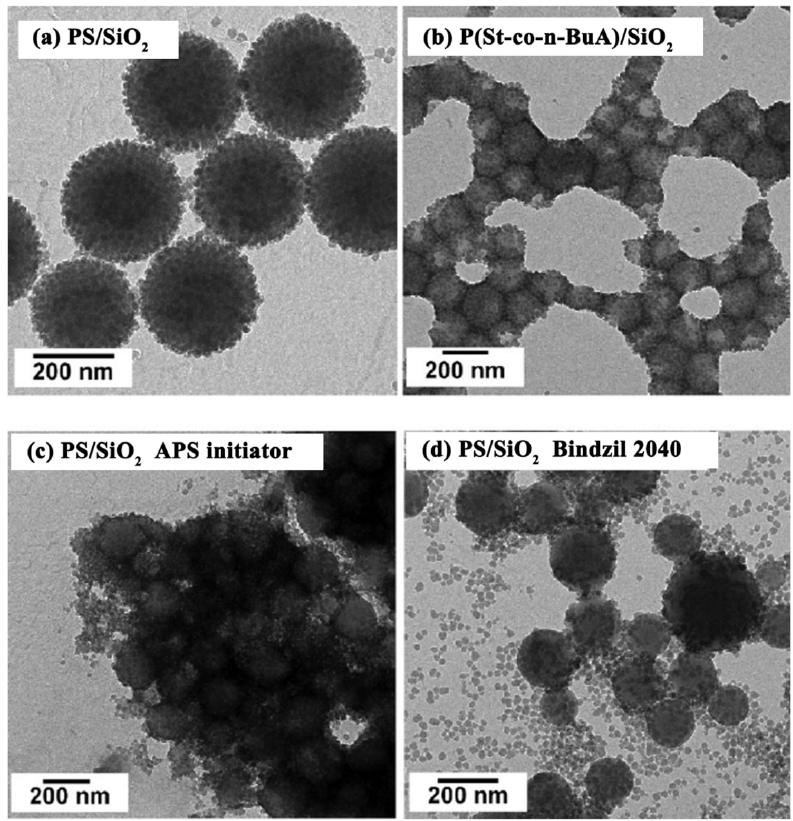
Figure 13. TEM images of: ( a ) PS/SiO 2 nanocomposite particles and ( b ) poly(styrene–co–n–butyl acrylate)/SiO 2 nanocomposite particles prepared by emulsion (co)polymerization using a cationic AIBA initiator at 60 ◦ C in the presence of a commercial glycerol–functionalized SiO 2 sol; ( c ) the iden- tical styrene homopolymerization in the presence of the same SiO 2 sol with an anionic APS initiator did not produce colloidally stable particles; ( d ) if AIBA–initiated styrene homopolymerization is conducted in the presence of a non–functionalized SiO 2 sol (Bindzil 2040), well–defined nanocompos- ite particles are not obtained and there is substantial excess SiO 2 sol. Reproduced from [100] with permission from John Wiley and